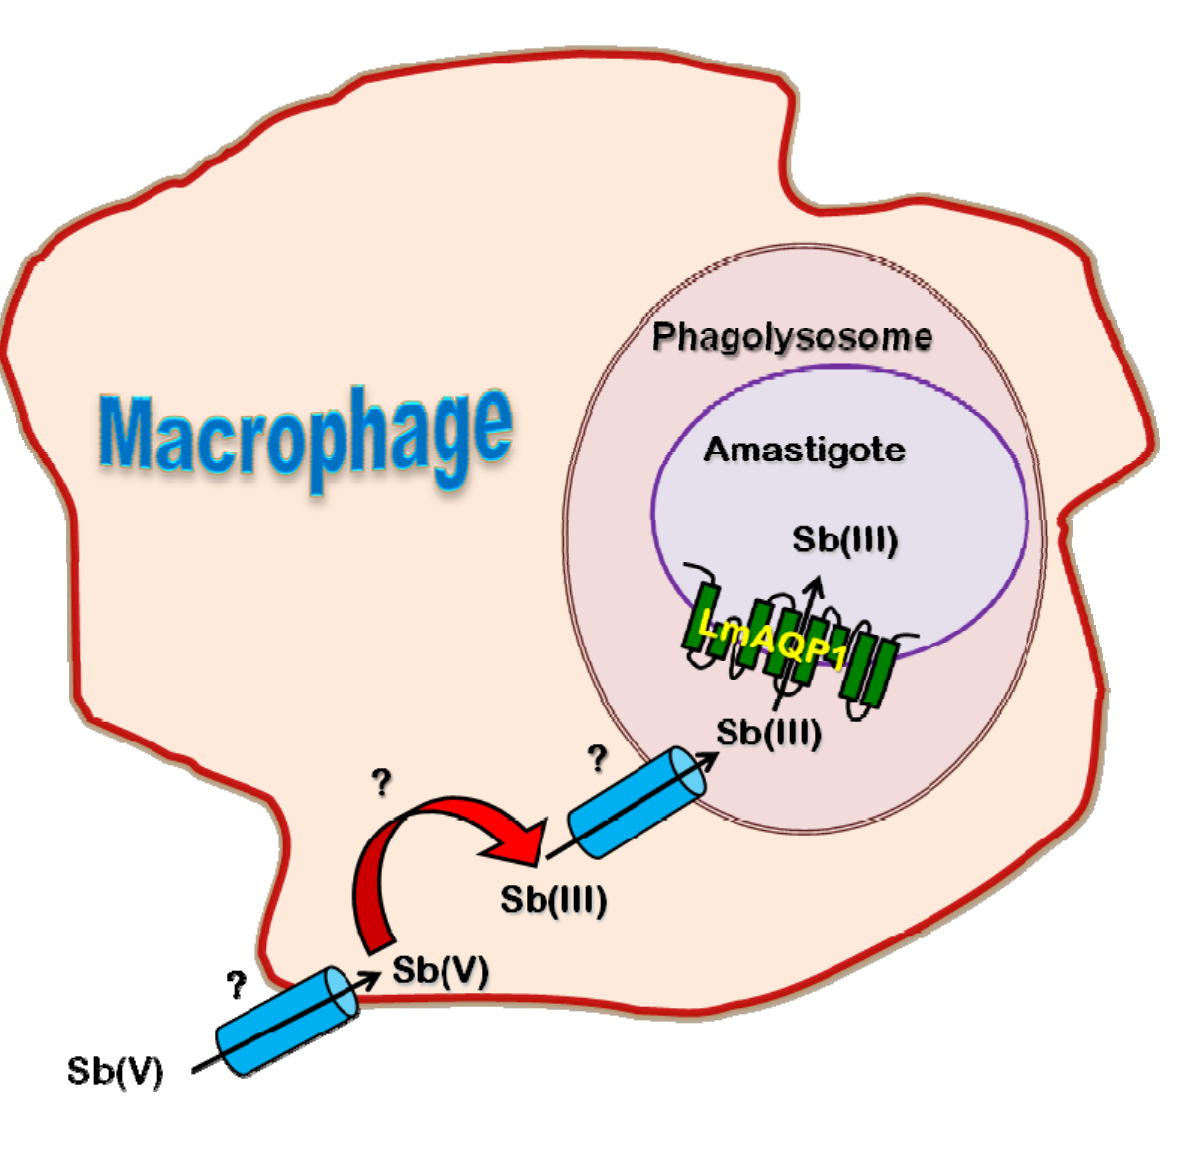
Figure 1. Diagrammatic representation of proposed antimonial transport mechanism in